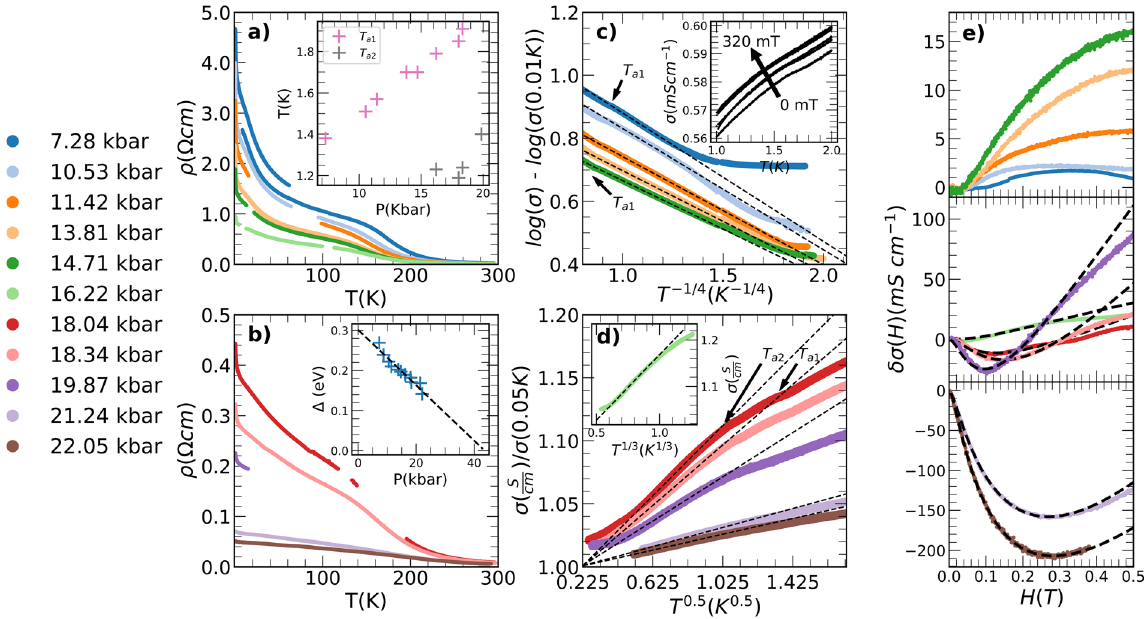
Fig. 1 Transport and magnetotransport data. a and b ρ ( T ) curves over the whole temperature and pressure range. Inset in a : characteristic temperatures of the two anomalies. Above 20 kbar, both anomalies seemingly disappear (or smear out). Inset in b : Development of the band gap with extrapolated fi t. (cid:5) (cid:6) 1 = 4 . The fi rst anomaly is marked by small black arrows for two pressures. Inset: plot of c Conductivity plots to demonstrate the VRH with σ / exp T 0 = T ffiffiffi p T the development of the anomaly under small magnetic fi elds at 13.81 kbar. d Conductivity plots to demonstrate σ / . Again, the two anomalies are marked by arrows for one pressure. Inset: Plot of the conductivity at 16.22 kbar. The σ ∝ T 1/3 law indicates critical behavior. e Magnetoconductance measurements at 500 mK for all pressures. In the lower and middle panel, curves are fi tted by using the fi tting function described by Eqs. (13) and (14).